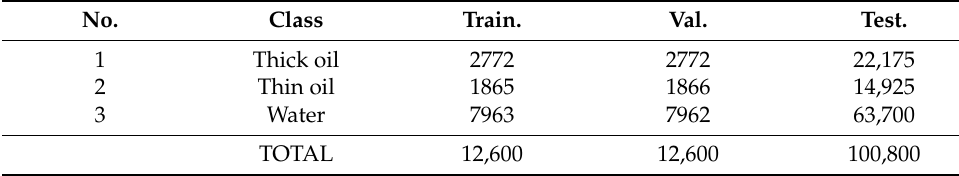
Table 3. Training, validation, and testing numbers in the dataset 1.